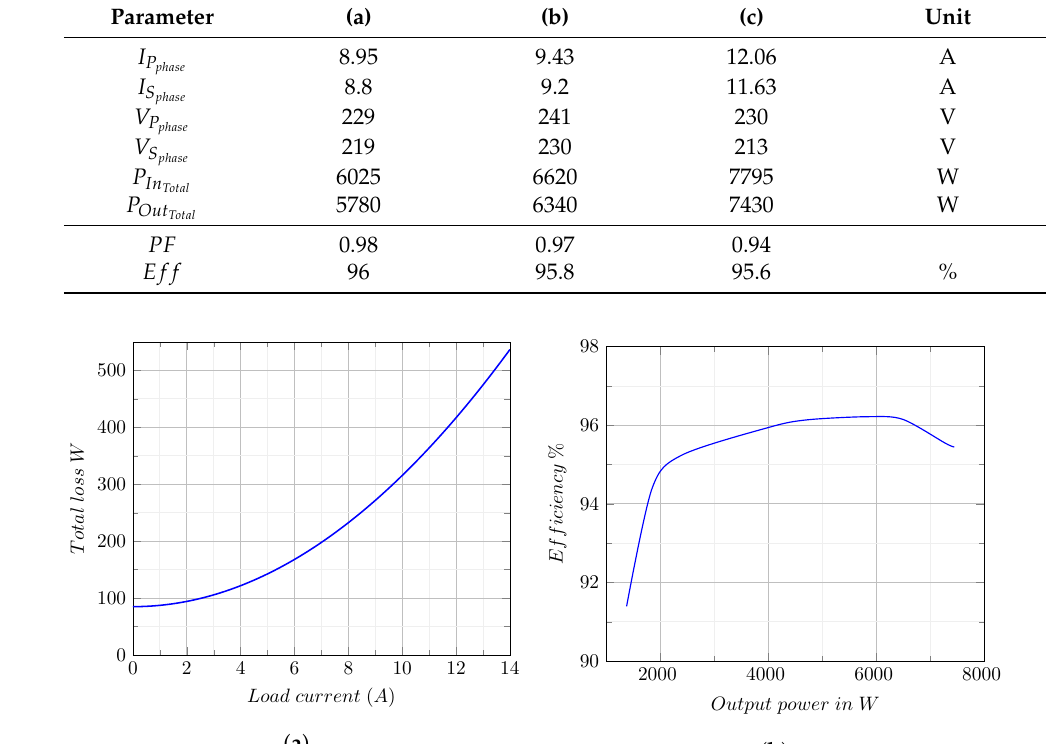
Table 6. Full-load test at (a) rated input voltage, (b) rated output voltage and (c) 1.3 PU load. Voltage and currents are averaged between phases.